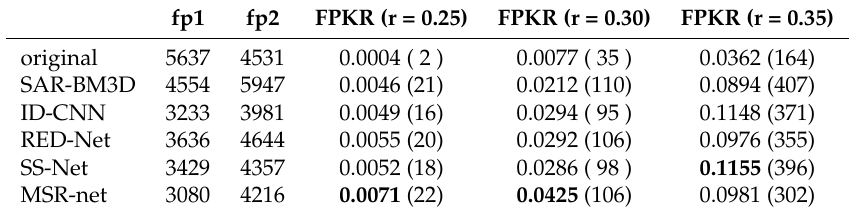
The value inside brackets is the number of feature points. The bold number represents the optimal value in each column. Table 7. FPKR results before and after despeckling for real SAR image.